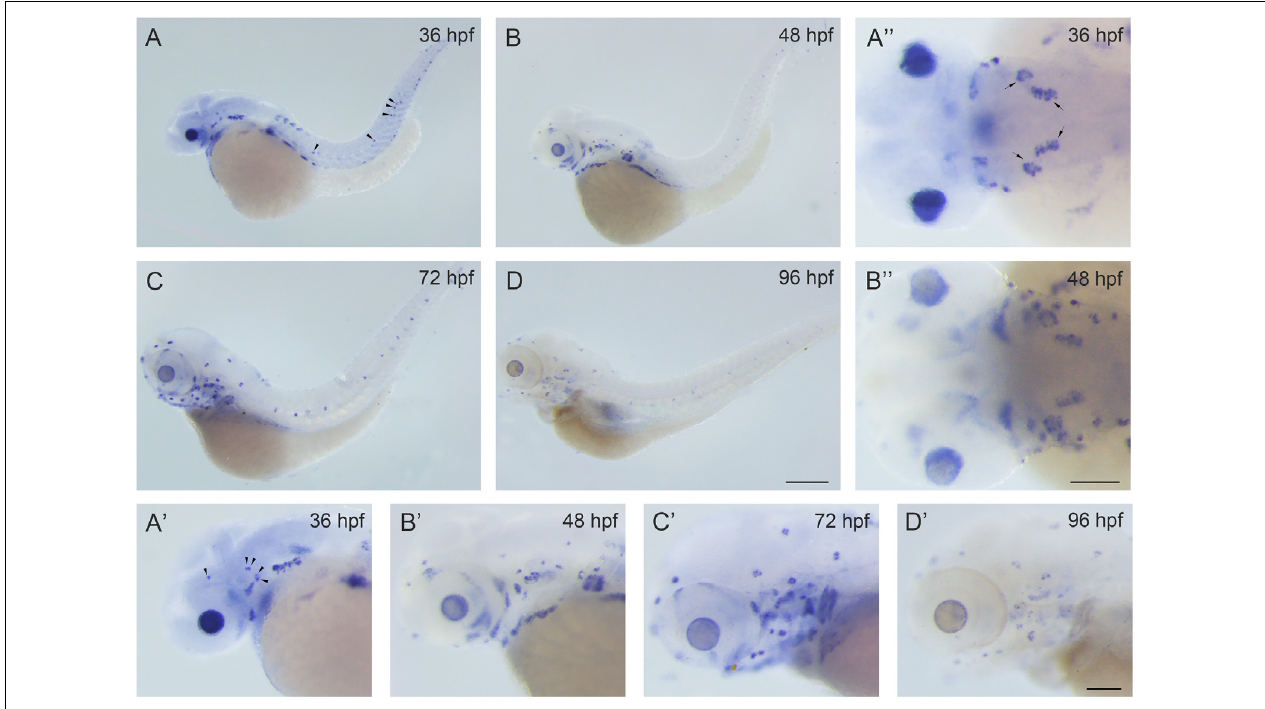
FIGURE 1 | Rbm24a is expressed in the otic vesicles and lateral line neuromasts of the zebrafish. Expression pattern of rbm24a during development was examined by performing in situ hybridization of zebrafish embryos at 36 hpf (A–A”) , 48 hpf (B–B”) , 72 hpf (C,C’) , and 96 hpf (D,D’) . Otic vesicles are indicated with arrows, and lateral line neuromasts are indicated with arrowheads. Scale bars, 0.25 mm in (A–D) , 0.1 mm in (A’–D’) and (A”,B”)